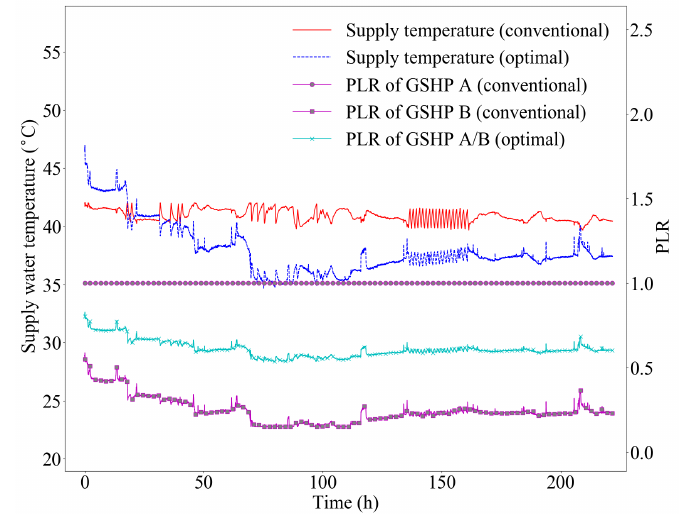
Figure 11. Comparison of operation strategy.